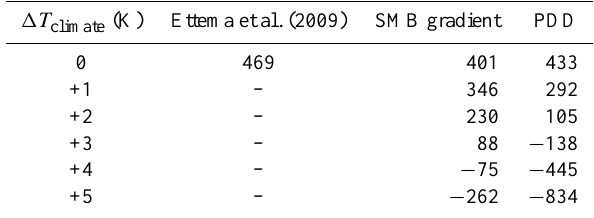
Table 2. Ice sheet integrated SMB as a function of 1T climate using the SMB gradient method and a PDD